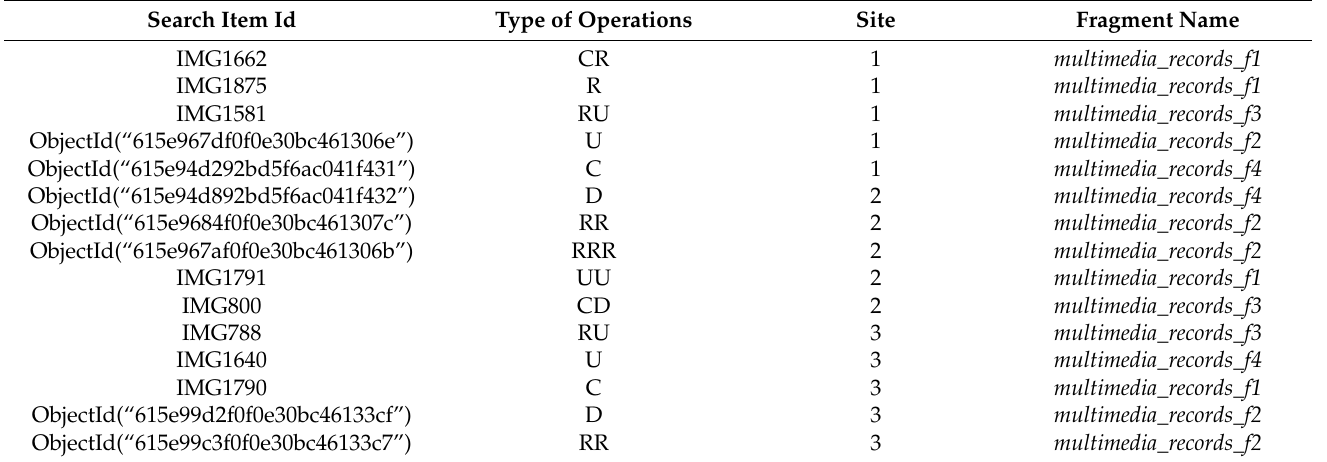
Table 6. Operations performed on the fragmented multimedia